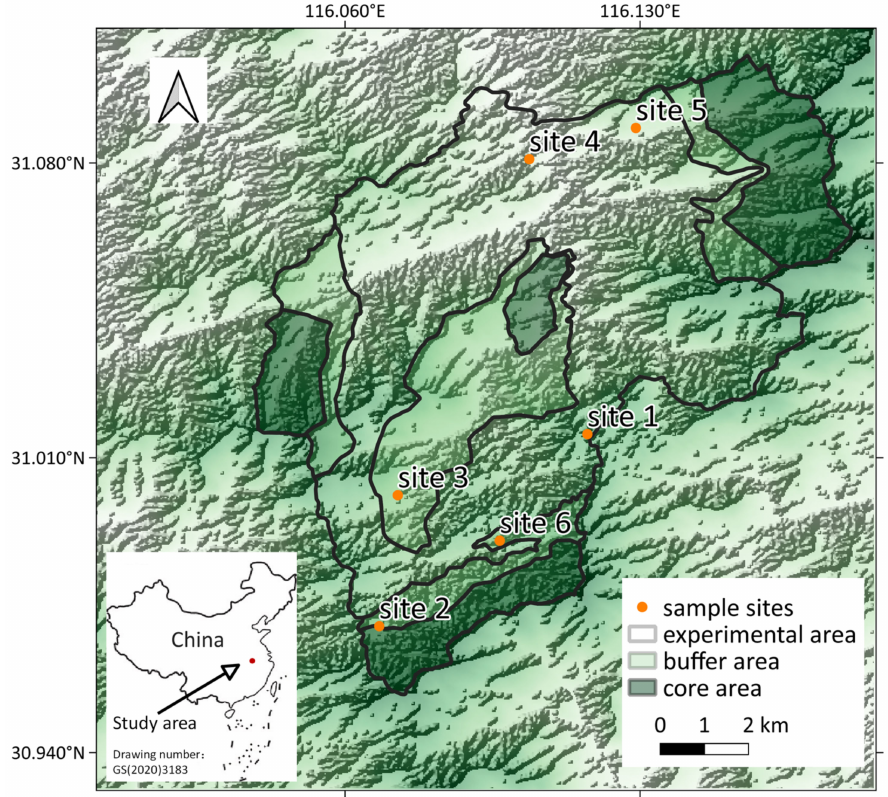
Figure 1. Study area with the geographical location of the six sampling sites in the YNNR